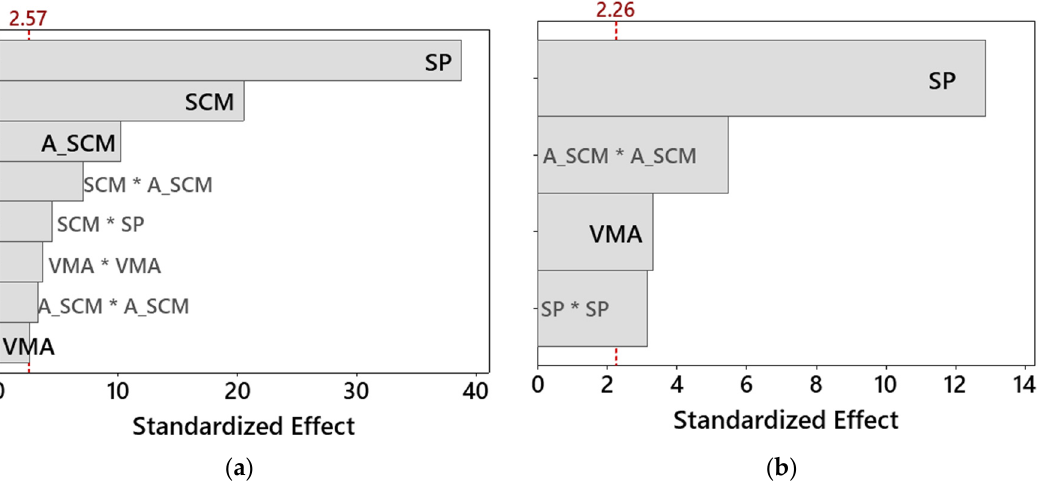
Figure 5. Pareto chart of the standardized effects for 2-day ( a ) and 28-day compressive strength ( b ).